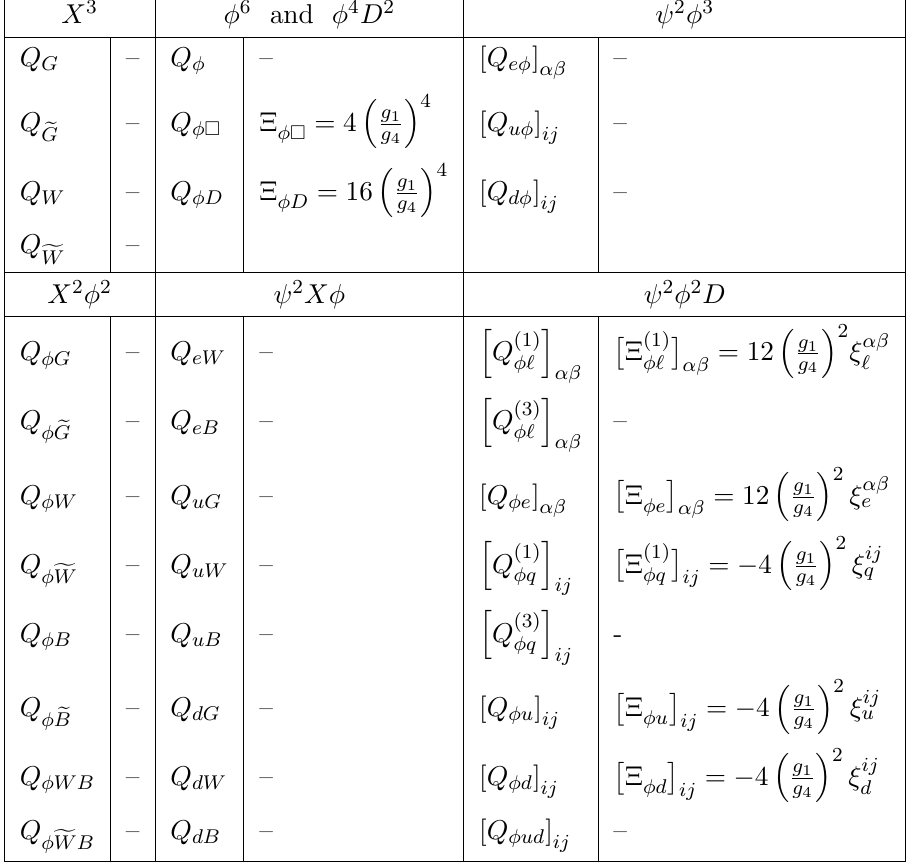
Table 4 . Wilson coe(cid:14)cients of operators other than four-fermion ones.